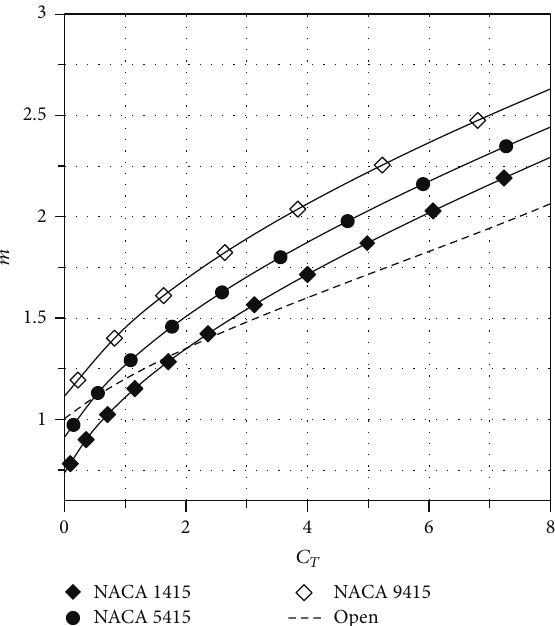
Figure 8: Effects of the profile camber on the duct thrust coefficient. Figure 9: Effects of the profile camber on the mass flow swallowed by the rotor.